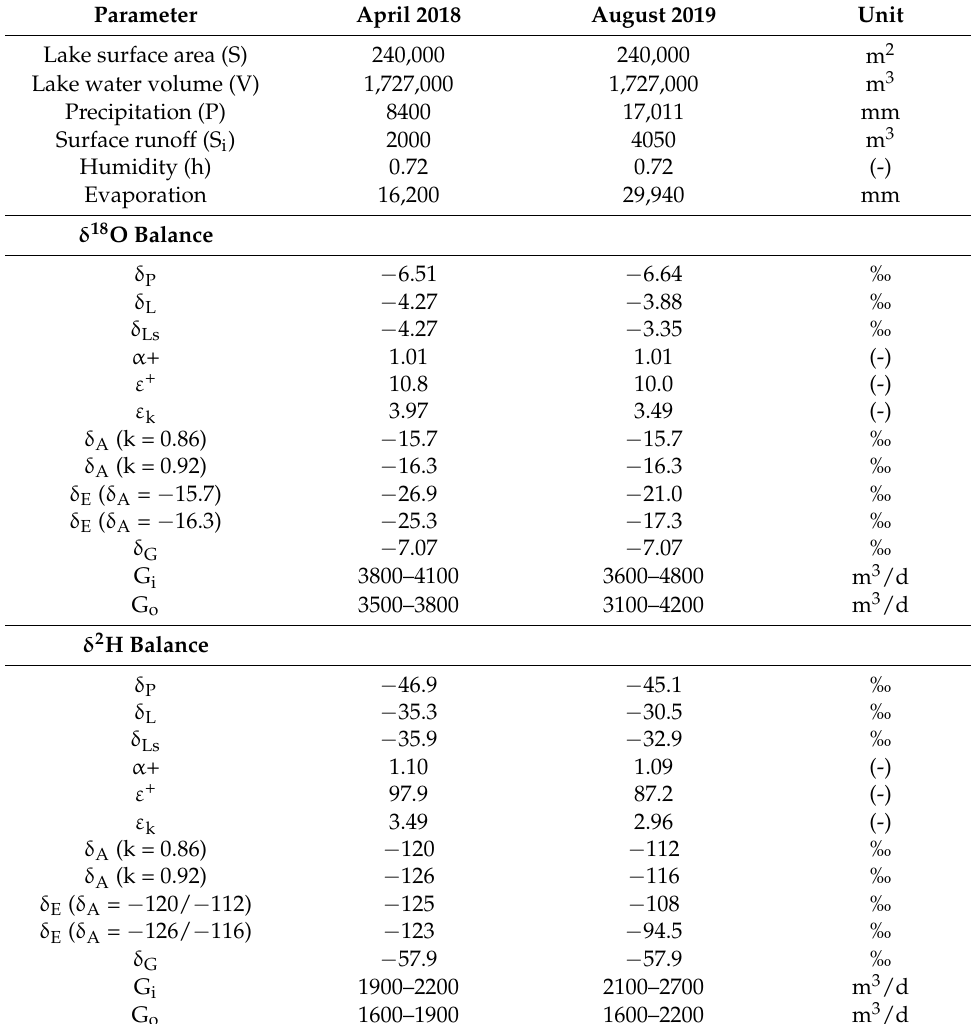
Table 2. Parameter used for solving the δ 18 O and δ 2 H mass